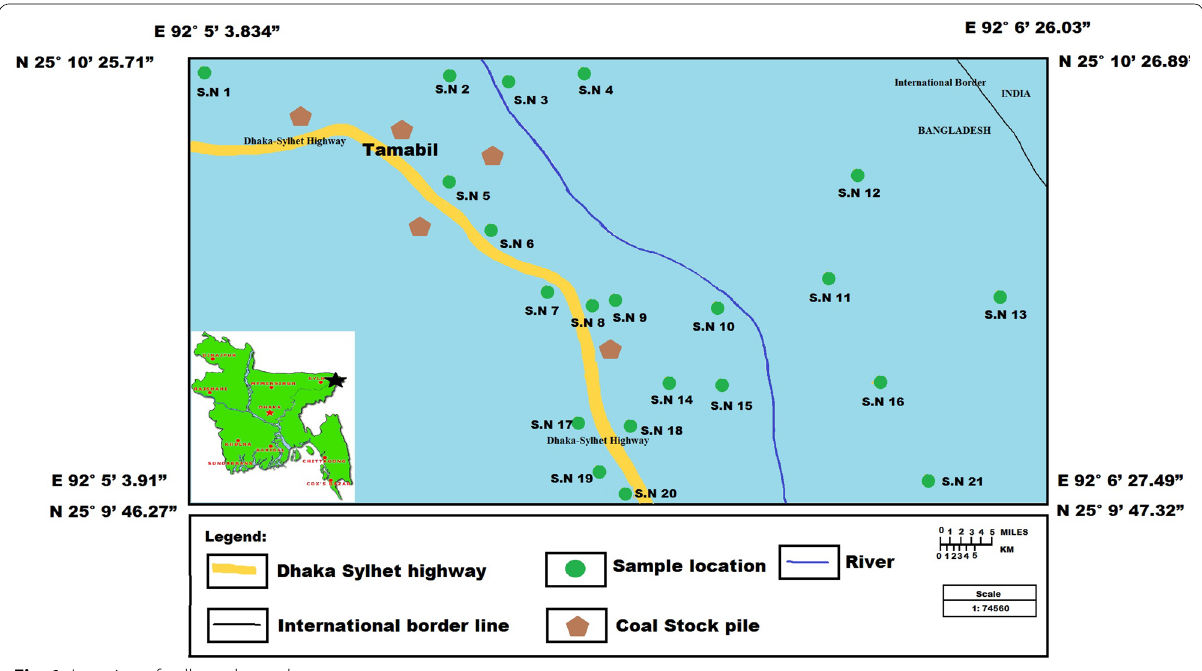
Fig. 1 Location of collected